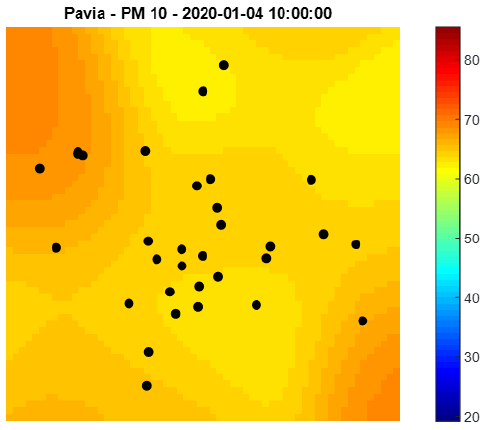
Figure 7. The interpolated continuous model for PM10; day selected is January 4th, 2020 and time shown is 10:00 AM